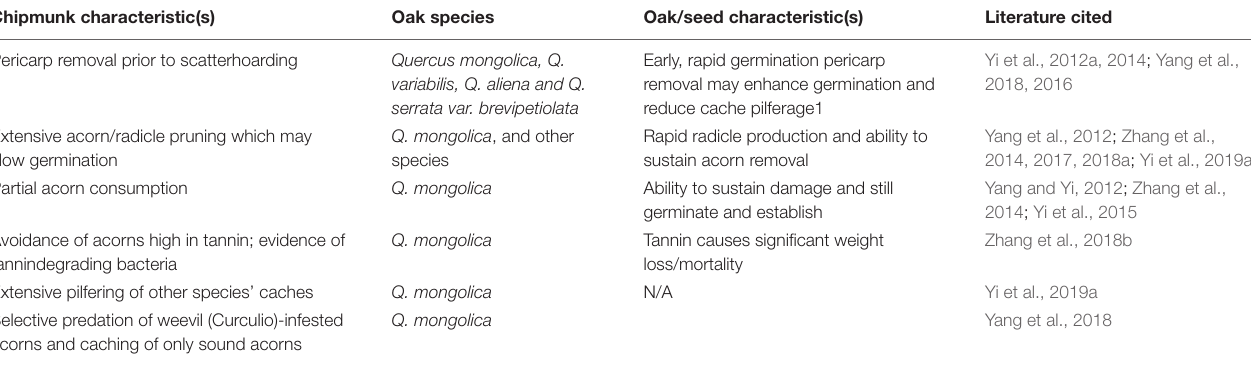
TABLE 2 | Summary of a suite of behavioral strategies employed by Siberian chipmunks ( Eutamias sibiricus ) to manage acorn scatterhoards. Chipmunk